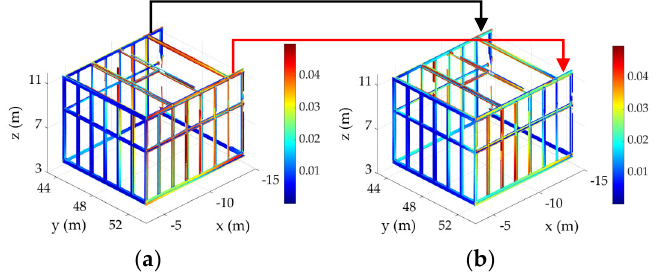
Figure 7. Distance of the point to the 3D element model using ( a ) only the initial reliable target-based registration and ( b ) the iterative closest point (ICP) fine registration [20].